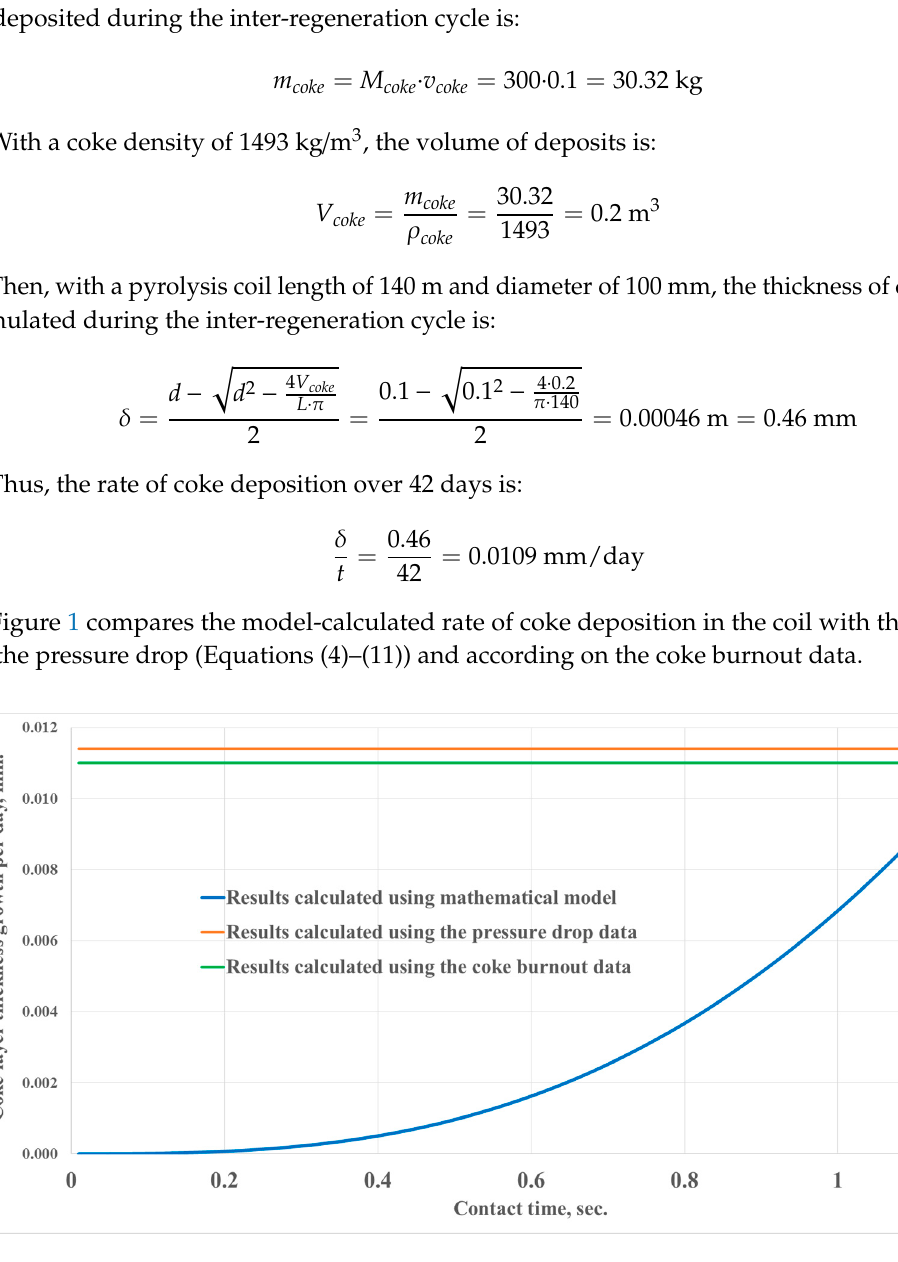
Figure 2. Coke layer thickness depending on the coil length at the end of the pyrolysis furnace coil.